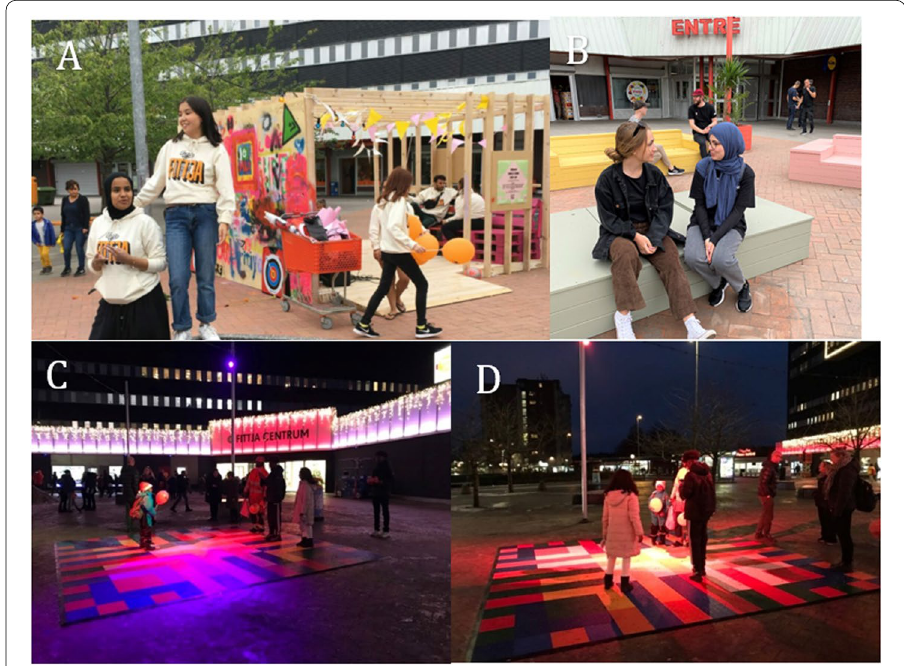
Fig. 7 Photos from both permanent and pop-installations inspired by the UGM project. Photo A : A pop-up activity cube (2019), photo by Global Utmaning. Photo B : A pop-up hangout park (2021), photo by Botkyrka kommun. Photo C and D : Inauguration of the new colorful light instalments and a pop-up dance floor on Fittja square (2021), photos by S.